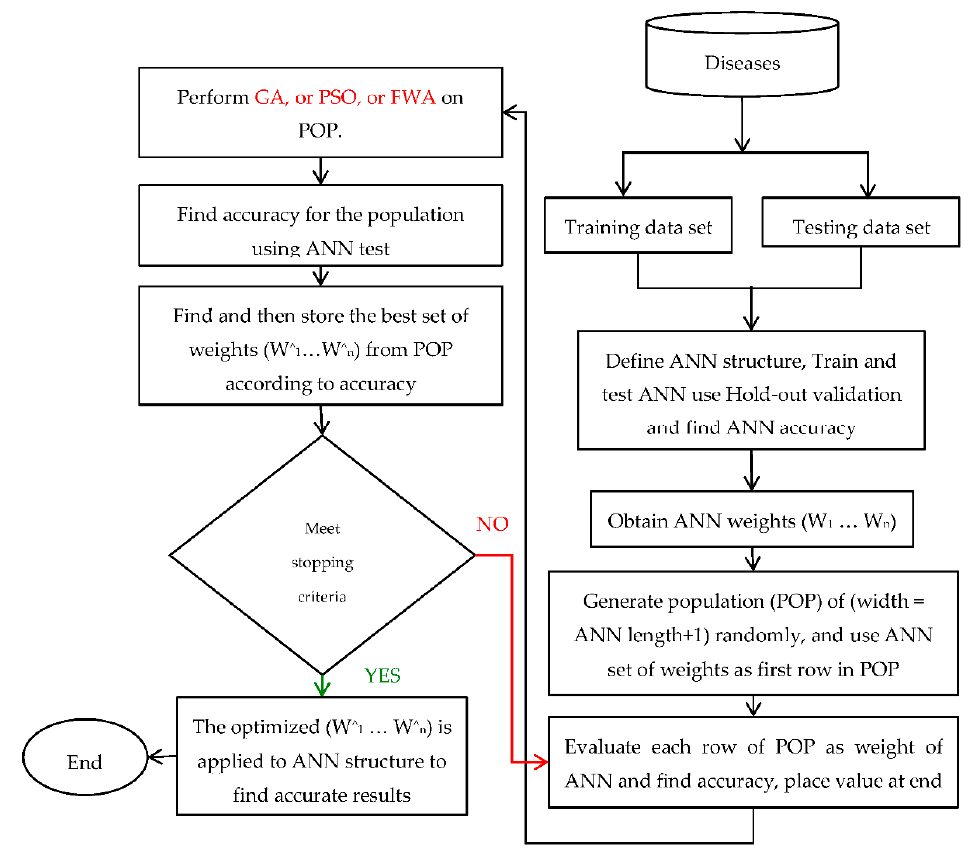
Figure 4. Flowchart of optimized classification by an Artificial Neural Network (ANN) with metaheuristic algorithms.